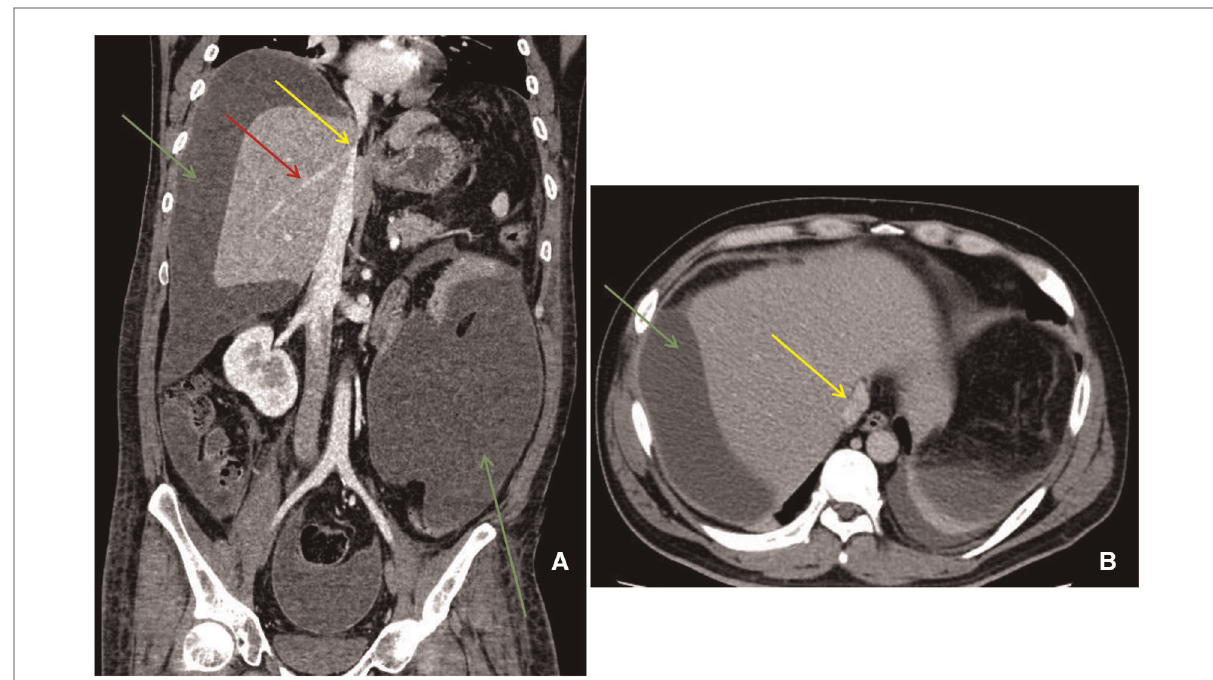
FIGURE 2 Abdominal enhanced CT manifestation. ( A ) (Coronal) a large amount of perihepatic and abdominal fl uid (green arrow) and stenosis of IVC (yellow arrow) and hepatic veins (red arrow). ( B ) (Horizontal) a large amount of perihepatic fl uid (green arrow) and stenosis of IVC (yellow arrow).